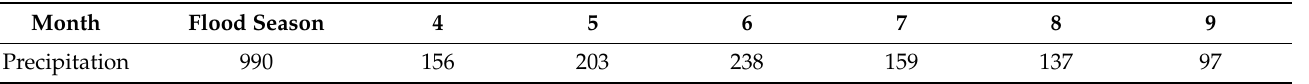
Table 2. Precipitation during the flood season and monthly in Dongting Lake Basin, unit: